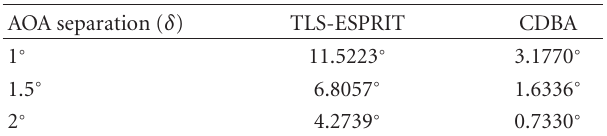
Figure 2: Root mean square error (RMSE) of angle estimation in degrees versus number of antenna doublets for ( θ 1,2 = 30 ◦ ,75 ◦ ). Table 1: Root mean square error (RMSE) of angle estimation in degrees for di ff erent AOA